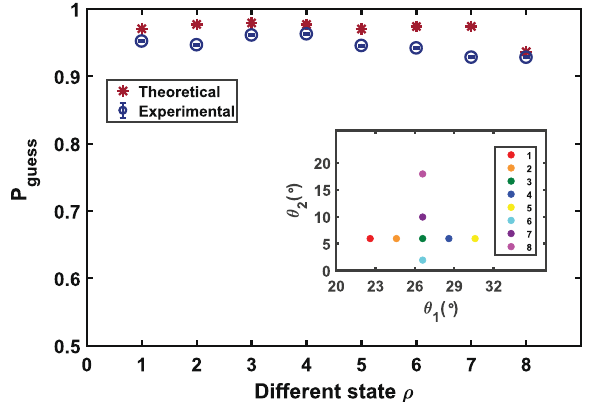
Fig. 5 Different strategies for the d = 3 guessing game. The probabilities of the successful guessing in the experiment are shown as the blue circles with the theoretically predicted values shown as the red stars. For each strategy, the probe state is prepared with H1, H2, and two HBDs in Fig. 3(b). The best-known strategy corresponds to data “ 3" and the corresponding setting of H1 ( θ 1 ) and H2 ( θ 2 ) for the input state preparation is shown as the green dot in the inset fi gure, meanwhile, the settings for other strategies are shown as the other colored dots. Notice that for the data point “ 8" the theoretically predicted value is much lower than for the other states. This is because the input state of data point “ 8" lies much further away from the best-known strategy of data point “ 3" than all the other considered states, as can be seen on the inset. More information about the settings of the waveplates H1, H2, Q1, H12 and the detailed numerical values of the corresponding guessing probabilities are given in Supplementary Note